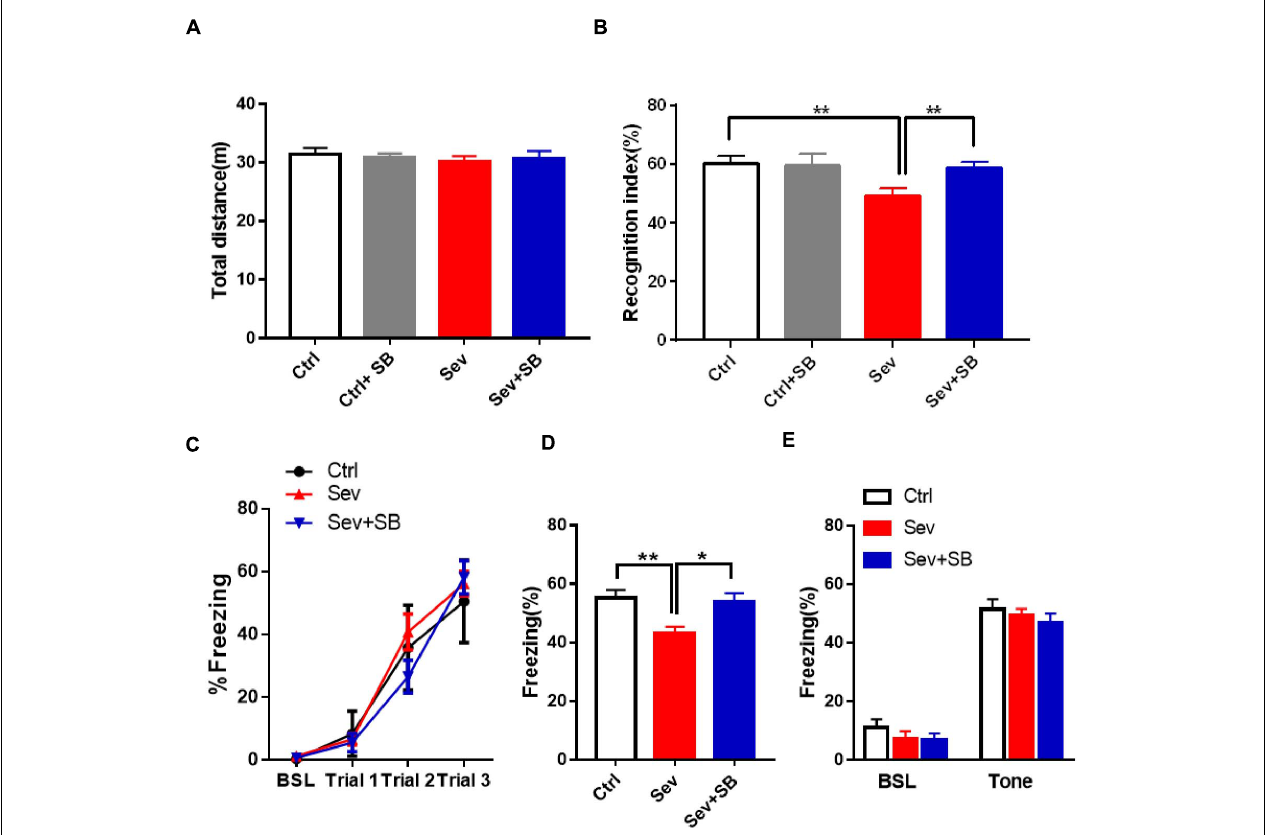
FIGURE 3 | SB 366791 mitigated sevoflurane-induced cognitive impairment in adult mice. (A) Total travel distance during 10 min locomotor activity test in the open field test of Ctrl ( n = 12), Ctrl + 500 µ g/kg SB 366791 ( n = 10), Sev ( n = 13), and Sev + 500 µ g/kg SB 366791 ( n = 14) mice. (B) Recognition index of Ctrl ( n = 10), Ctrl + 500 µ g/kg SB 366791 ( n = 10), Sev ( n = 13), and Sev + 500 µ g/kg SB 366791 ( n = 14) mice [one way ANOVA, F ( 3 , 43 ) = 5.8, p = 0.0021]. (C) Percentage of freezing in Ctrl ( n = 12), Sev ( n = 12), and Sev + 500 µ g/kg SB 366791 ( n = 10) mice during fear conditioning training. (D) Percentage of freezing in Ctrl ( n = 12), Sev ( n = 12) and Sev + 500 µ g/kg SB 366791 ( n = 10) mice during the contextual memory test [one way ANOVA, F ( 2 , 31 ) = 6.9, p = 0.0034]. (E) Percentage of freezing of Ctrl ( n = 12), Sev ( n = 12), and Sev + 500 µ g/kg SB 366791 ( n = 10) mice during the cued test. Data are presented as the mean ± SEM. ANOVA followed by Bonferroni post hoc test. * p < 0.05; ** p < 0.01. Ctrl, control; Sev, sevoflurane; SB, SB